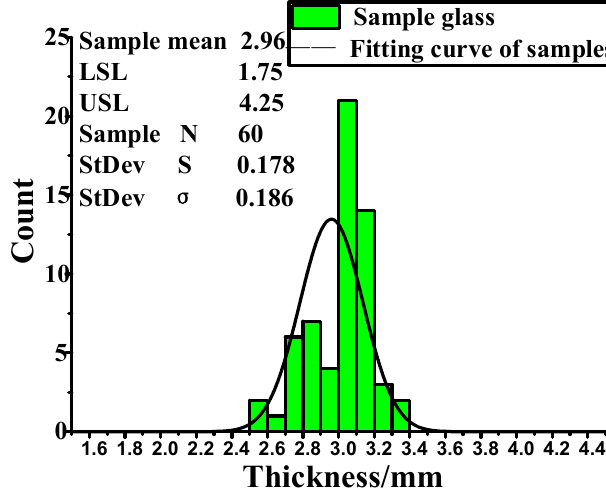
Figure 19. Sample analysis diagram of window glass.